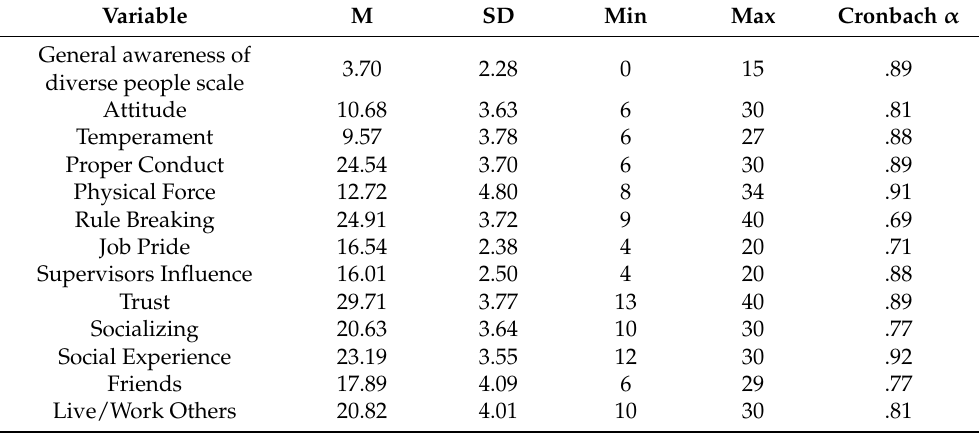
Table 3. Descriptive statistics for PRs and PSOs perceptions of awareness of diverse community generally, during times of victimization and entering the criminal justice